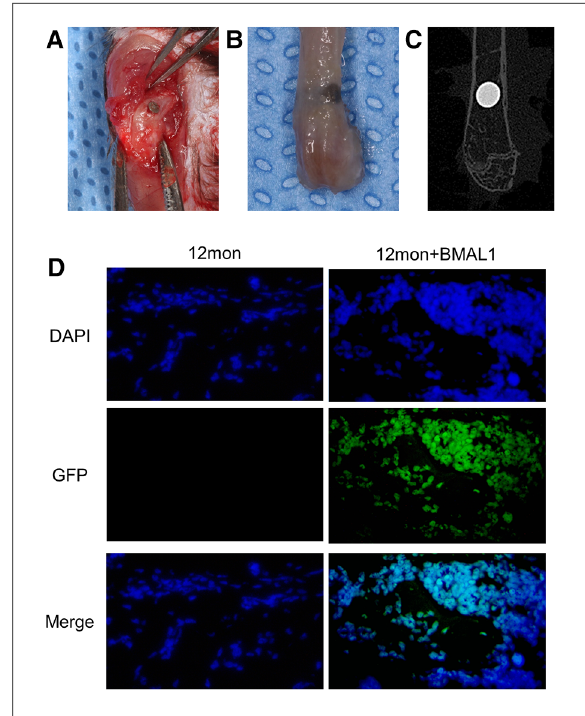
FIGURE 3 Representative images of implant surgery. ( A ) Titanium implants inserted into the distal end of femurs. ( B ) Representative image of femur with implant. ( C ) X-ray inspection of femur with implant. ( D ) Immuno fl uorescence proved positive expression of GFP in transfection